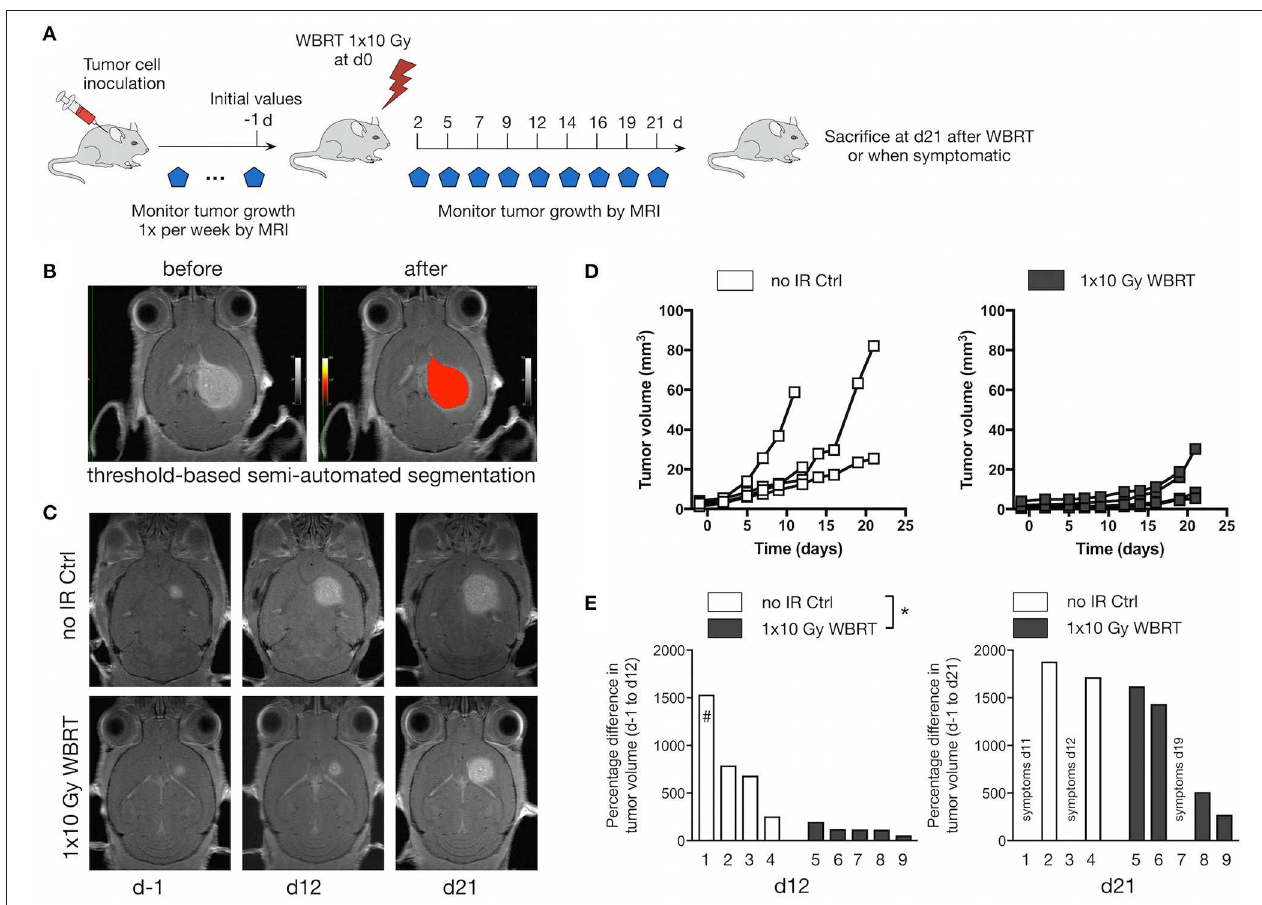
FIGURE 3 | Therapeutic response to WBRT in BrM. (A) Schematic depicting the experimental design to follow tumor progression after WBRT in BrM. (B) Representative MR images showing detection and volumetric assessment of metastatic lesions using the threshold-based semi-automated segmentation tool (Chimaera GmbH). (C) Representative MR images of tumor-bearing mice with and without WBRT at different time points. (D) Quantification of the increase in tumor volume over time in tumor-bearing no-IR control mice ( n = 4) and in response to 1 × 10Gy WBRT ( n = 5) using MRI. Curves depict tumor growth of individual mice. (E) Waterfall plots depict the percent increase in tumor volume on d12 and d21 relative to d-1. #Data shown for Mouse 1 were acquired on d11. P -values were obtained using two-way ANOVA and unpaired two-sided Student’s t -test. * P < 0.05.